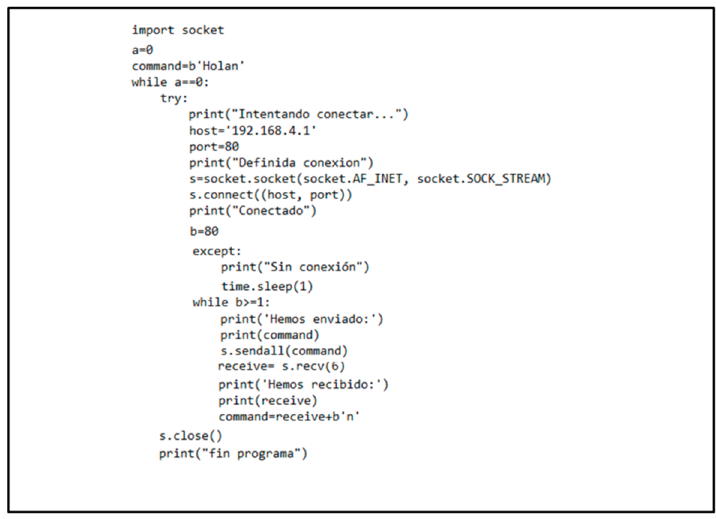
Figure A3. Raspberry Pi programming for embedded Wi-Fi.